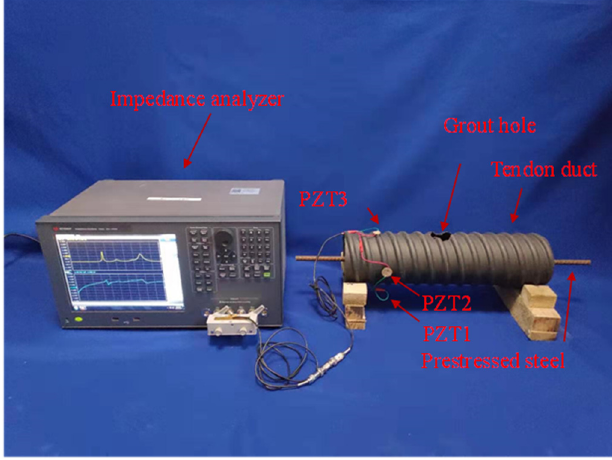
Figure 5. Experimental setup.